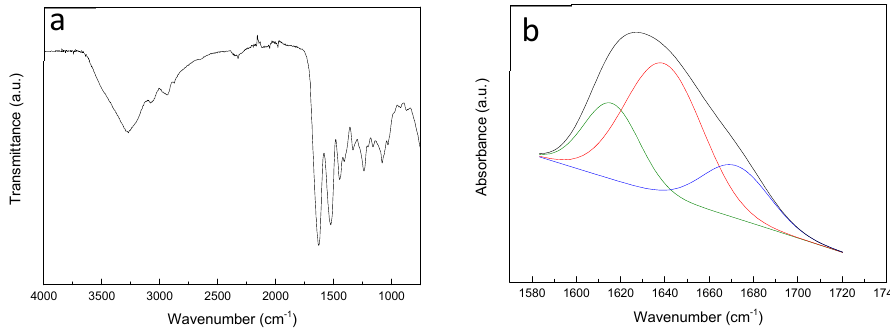
Figure 1. ( a ) FTIR spectra of fish scale gelatin and ( b ) curve fitting spectra of amide I. Gelatin is a semi-crystalline biopolymer with both crystalline and amorphous